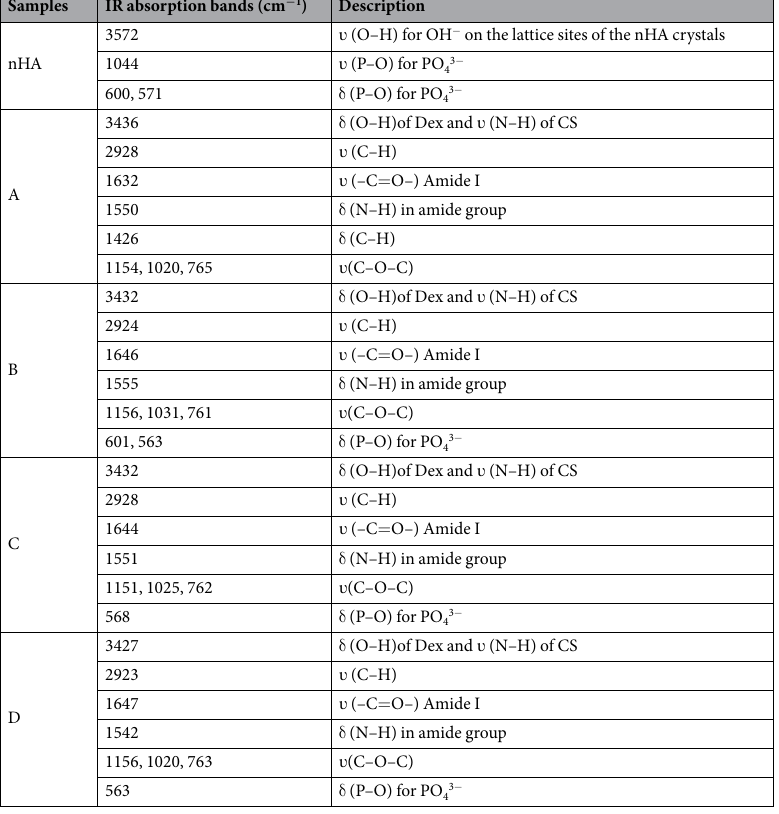
Table 2. Assignment of FTIR spectra of nHA, Dex-CS and Dex-CS/nHA composites presented in Fig.